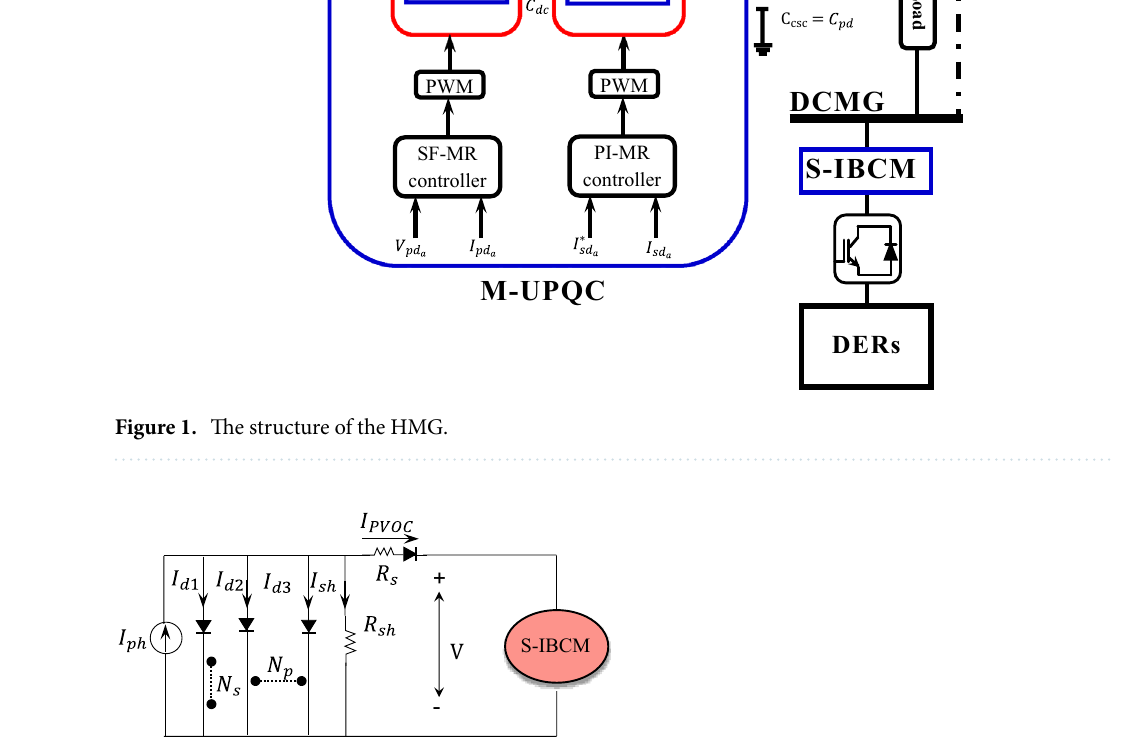
Figure 2. The equivalent circuit of the PV